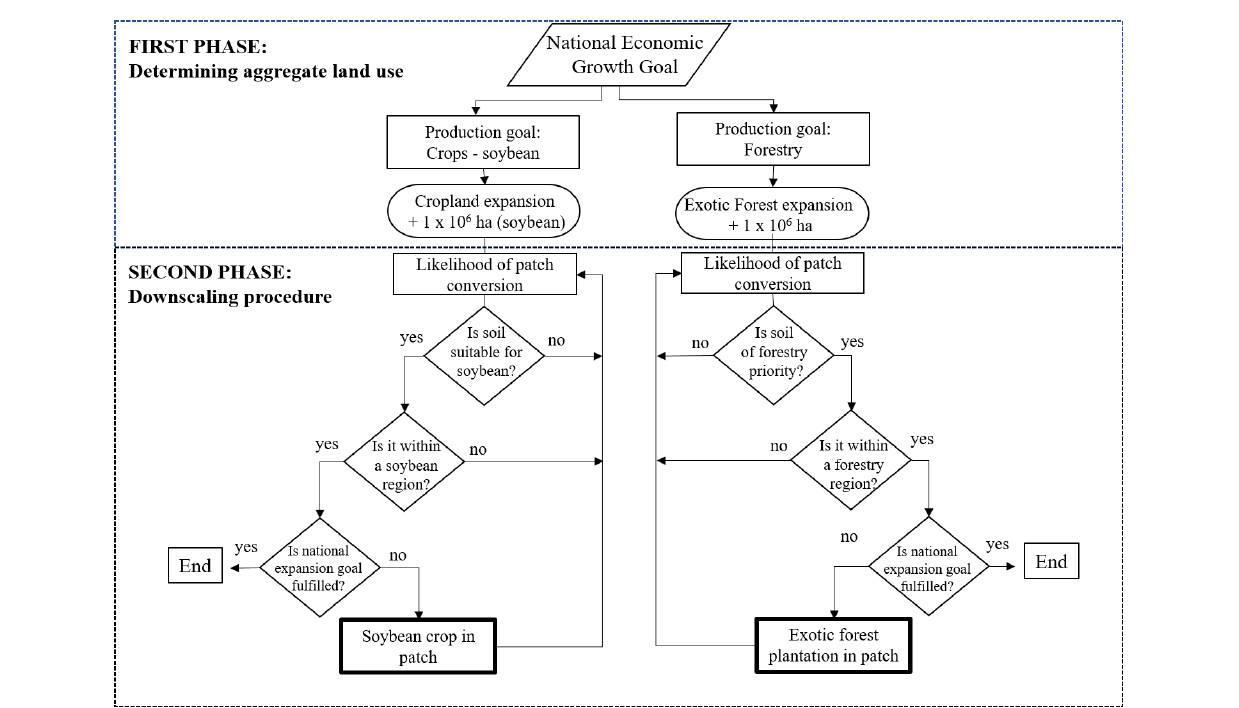
Fig. 1 . Flowchart describing the procedure used to build the land-use scenario for